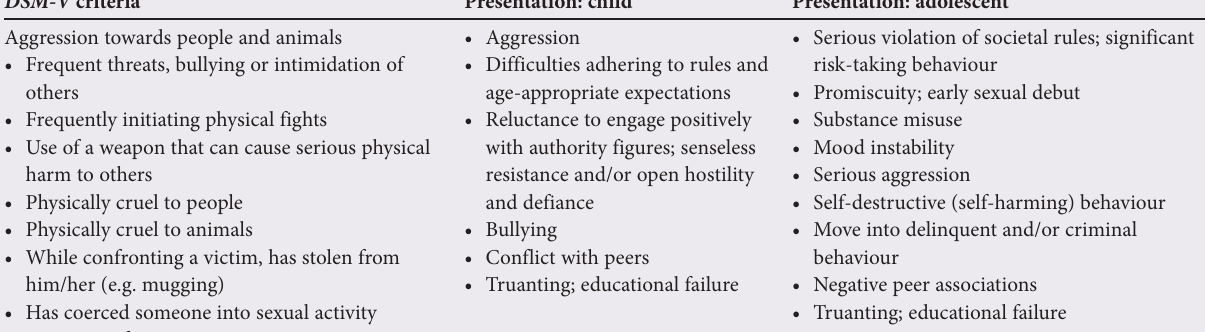
Table 10. Conduct disorder in children and adolescents DSM-V criteria